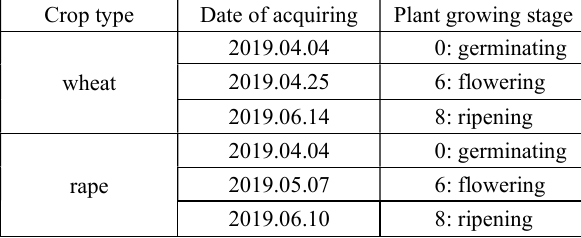
Table 2. Flight mission time